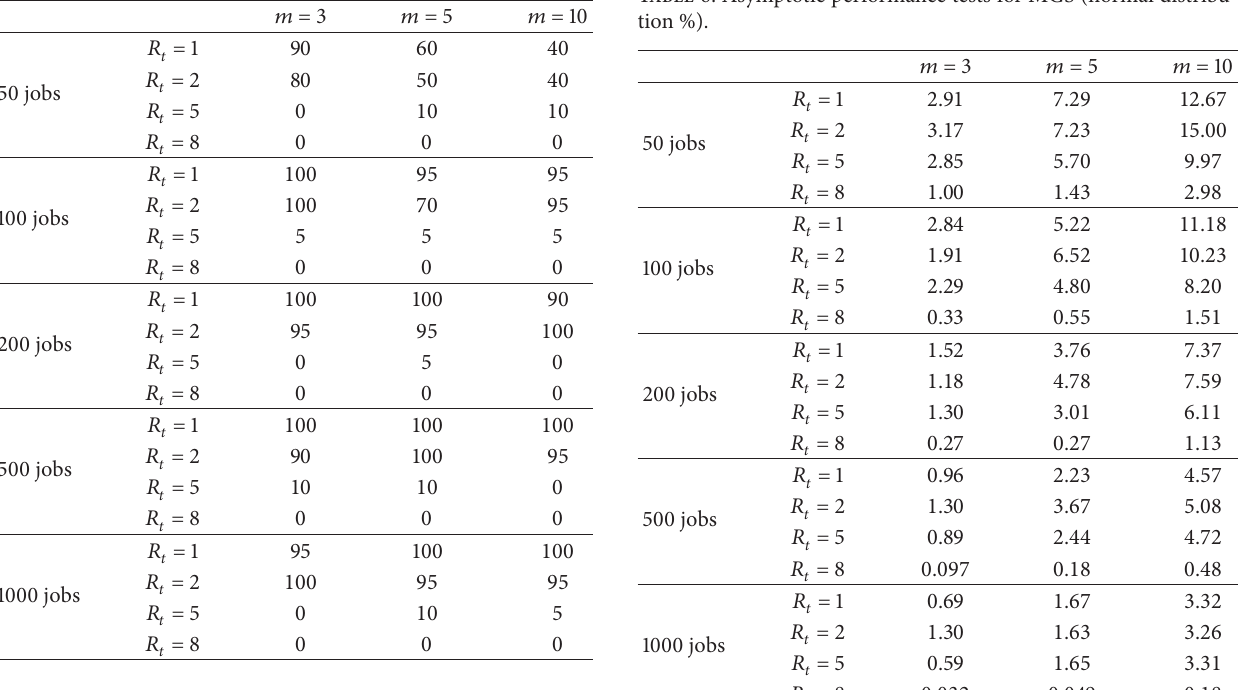
Table 4: Dominance tests of DSJF (normal distribution %).